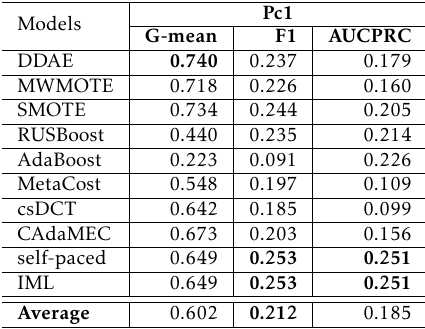
Table 19. Overall Results for Pc1 Dataset Models